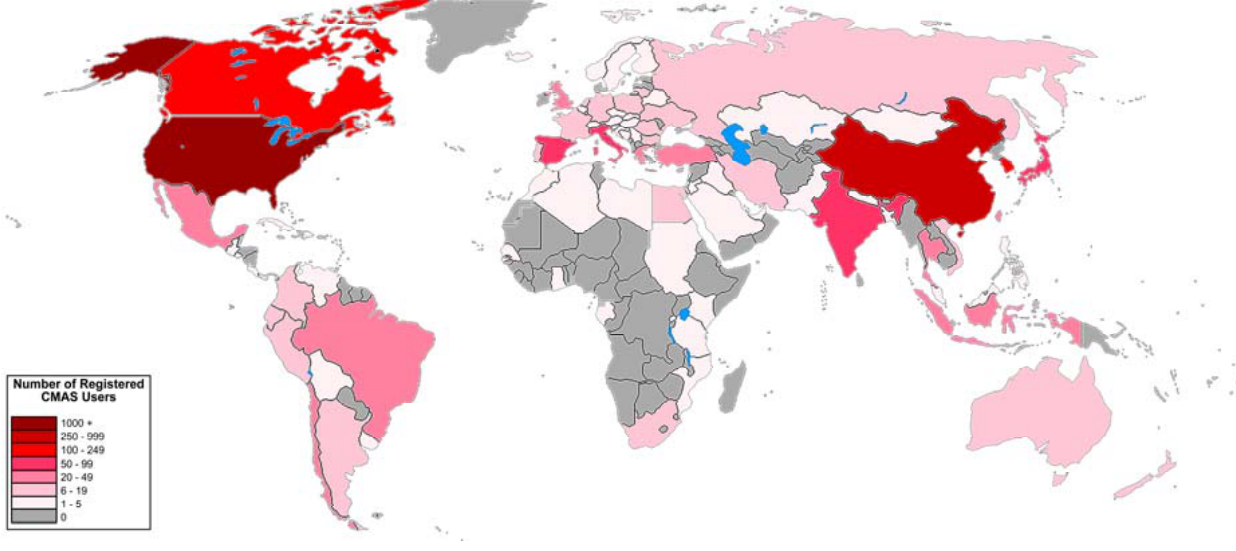
Fig. 1. Number of users registered with the Community Modeling and Analysis System (CMAS) Center (by country) as of Fall 2008. Image courtesy of the CMAS